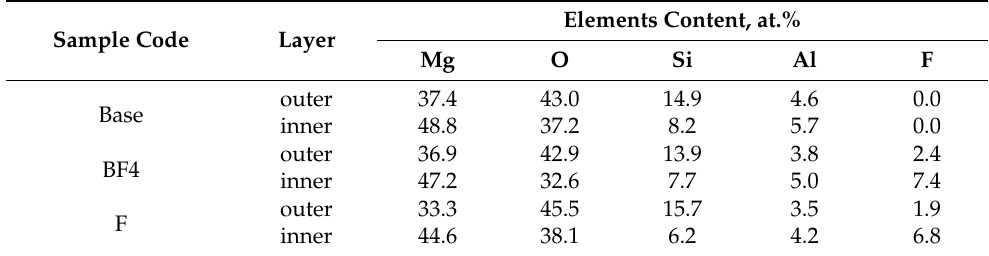
Table 6. Elemental contents (in atomic percentage) determined by EDS for the coatings obtained in different electrolytes.